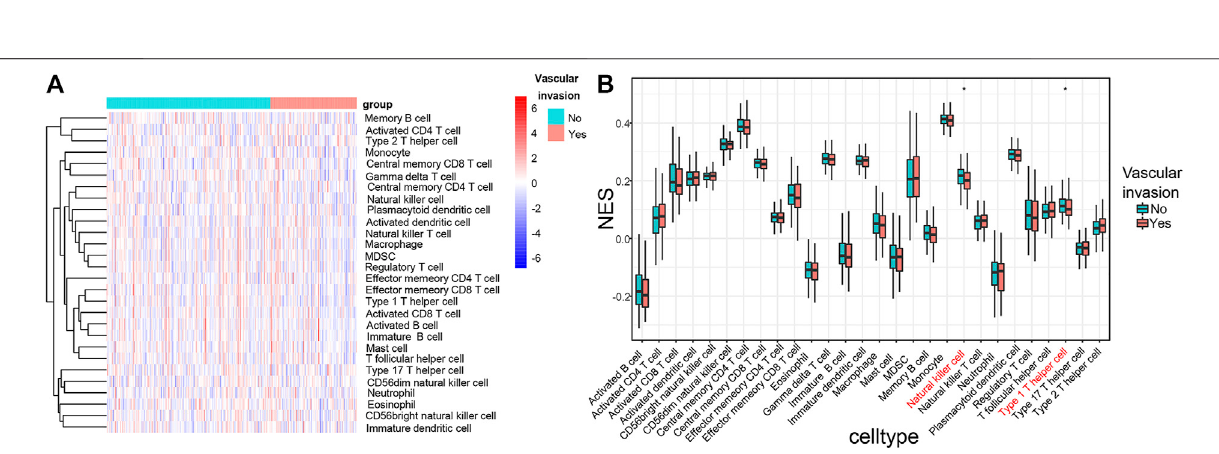
FIGURE8|(A) Heatmapoftumor-in fi ltratingimmunecellsintumortissuesinpatientswithprimaryHCCandHCCwithvascularinvasion.Annotationsontopshow the clustering of the samples. Green represents primary HCC; red represents HCC with vascular invasion. (B) Bar plot for comparing the proportions of immune cells in primary HCC and HCC with vascular invasion. The proportions of NK cells ( p < 0.05) and type 1 T helper cell ( p < 0.05) in HCC with vascular invasion are relatively lower than those in the primary HCC with vascular